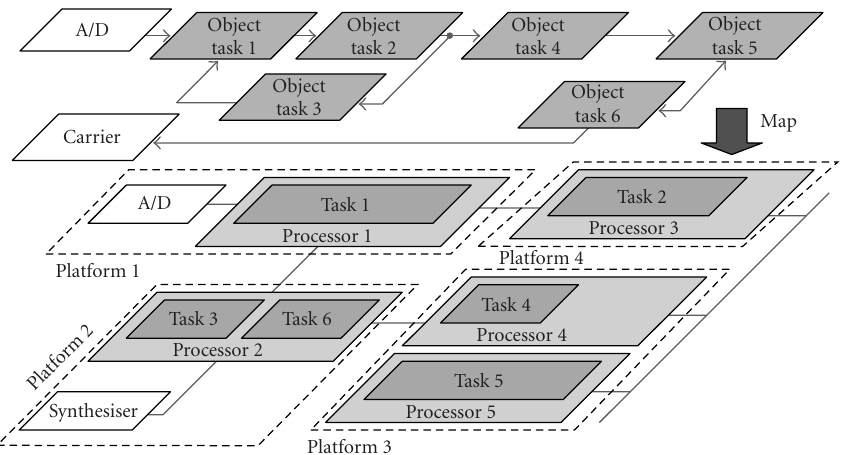
Figure 3: Sample mapping